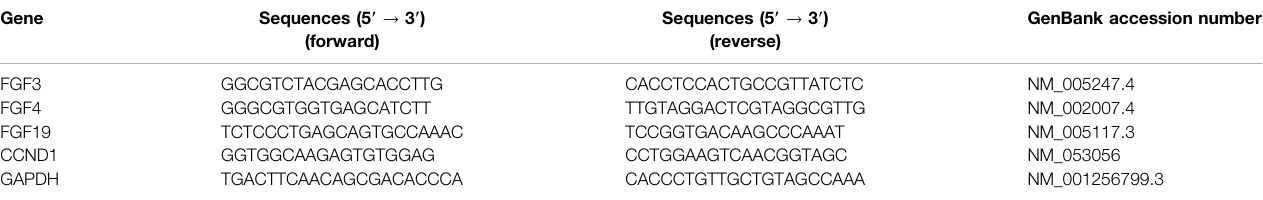
TABLE 2 | Primers used for real-time quantitative